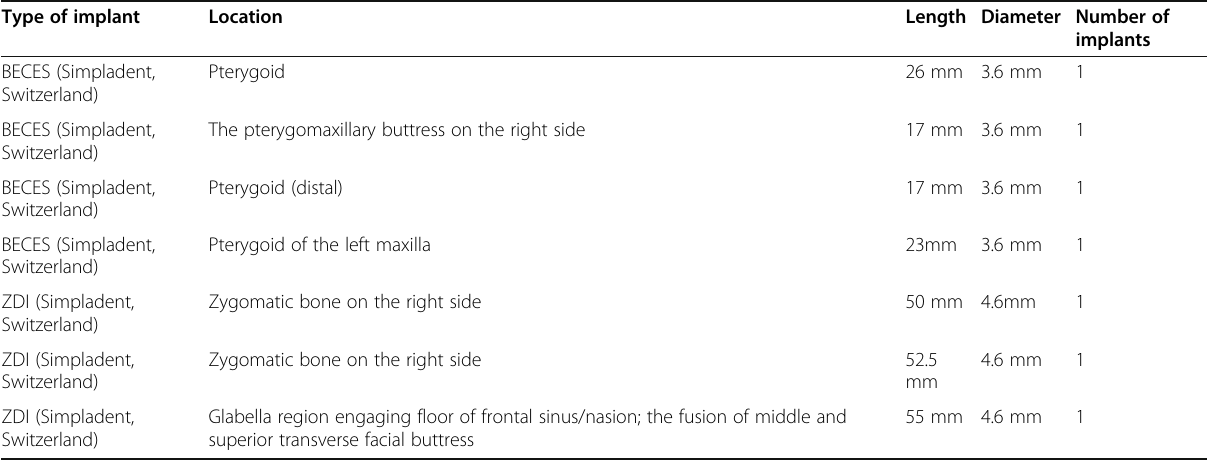
Table 1 Types of implants